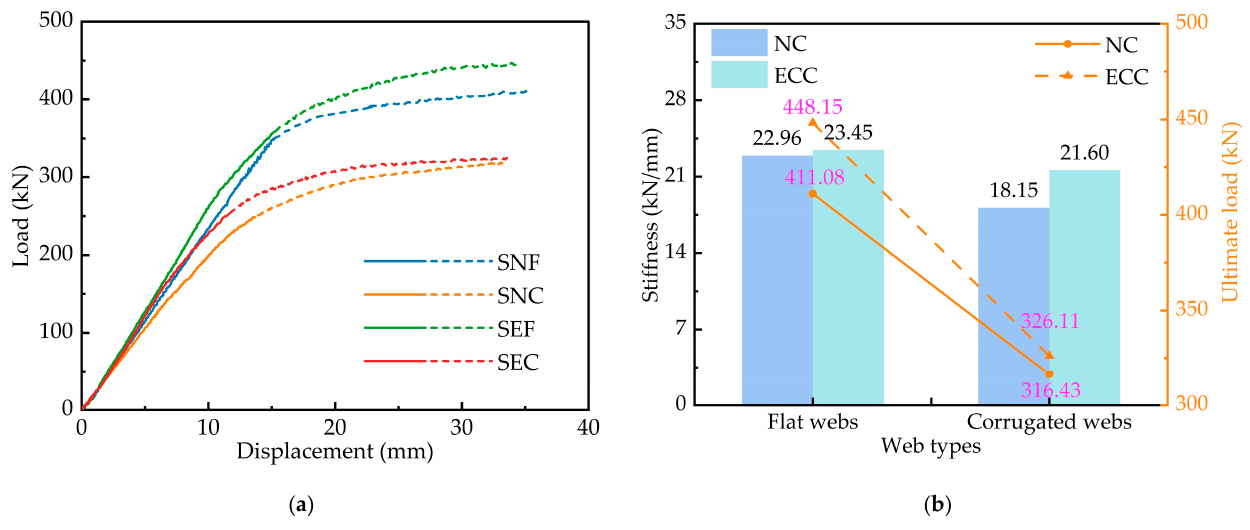
Figure 6. Comparison of specimens: ( a ) load-deflection curves; ( b ) stiffness and ultimate